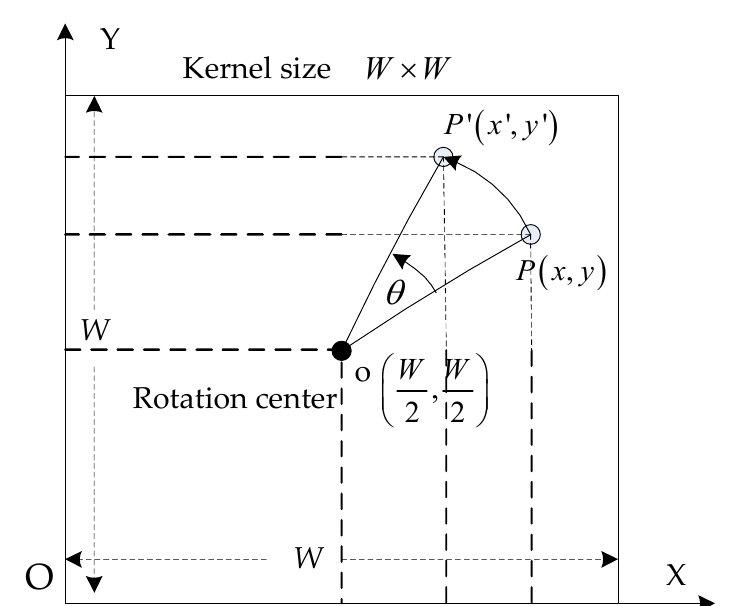
Figure 5. Calculating the rotation matrix of the Gaussian kernel. The rotation center is on the kernel center. ◦ ◦ ◦ ◦ Figure 6 shows several Gaussian kernels rotated by the optimal set of θ = 22 , 38 , 90 , and 178 ◦ obtained above and θ = 112.5 , one of the eight uniformly-distributed values commonly used in traditional UCM algorithms, respectively. The results show that the features of the horizontal catenary bracket, the vertical catenary column and the declining track are strengthened obviously in the first four filters, contrasting with the feature extraction equality in the fifth filter. The universality of using 8 or 16 uniform values in di ff erent angle θ causes a redundant calculation when applied to the railway scene. Therefore, adjusting a smaller number of θ adaptively to filter the feature map can accelerate the boundary weighting to generate the fragmented